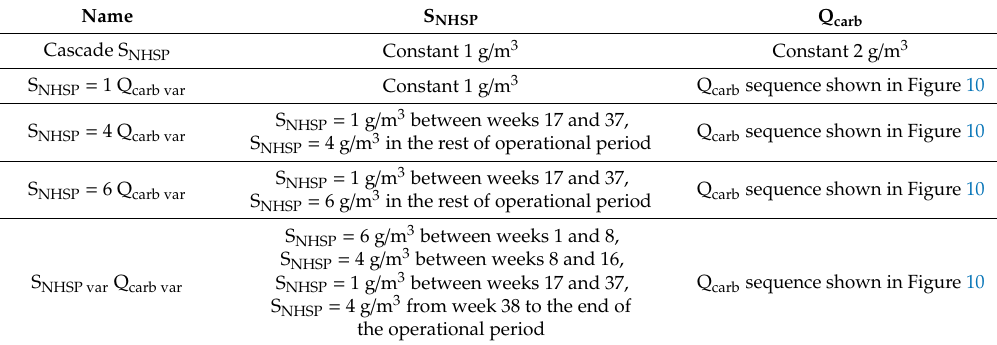
Table 12. Alternative strategies proposed to improve environmental and operation